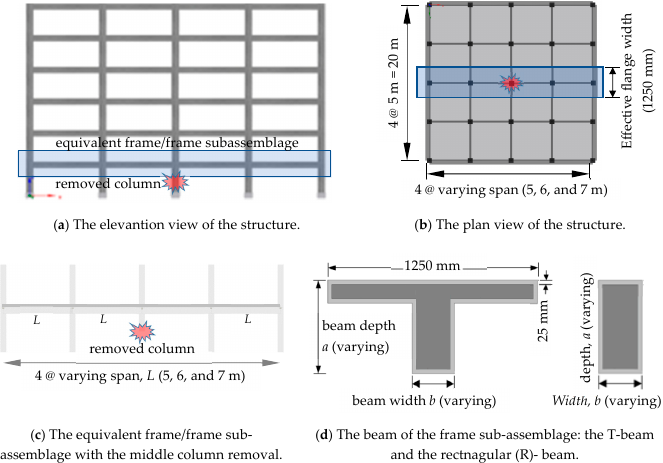
( d ) The beam of the frame sub-assemblage: the T-beam and the rectnagular (R)- beam. Figure 1. The structural framing of the building and the sub-assemblage configuration. Varying design options with various sectional dimensions (i.e., beam depth, width, slab thickness, and corresponding reinforcement ratios) and various spans were considered in this study.